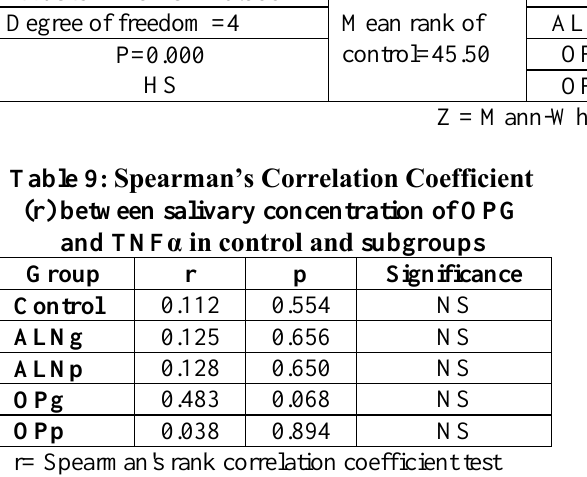
Table 8: Dun test for multiple comparisons of subgroups with control for salivary TNF-α concentration. Statistical Test Comparison Mean rank Kruskall-Wallis = 79.358